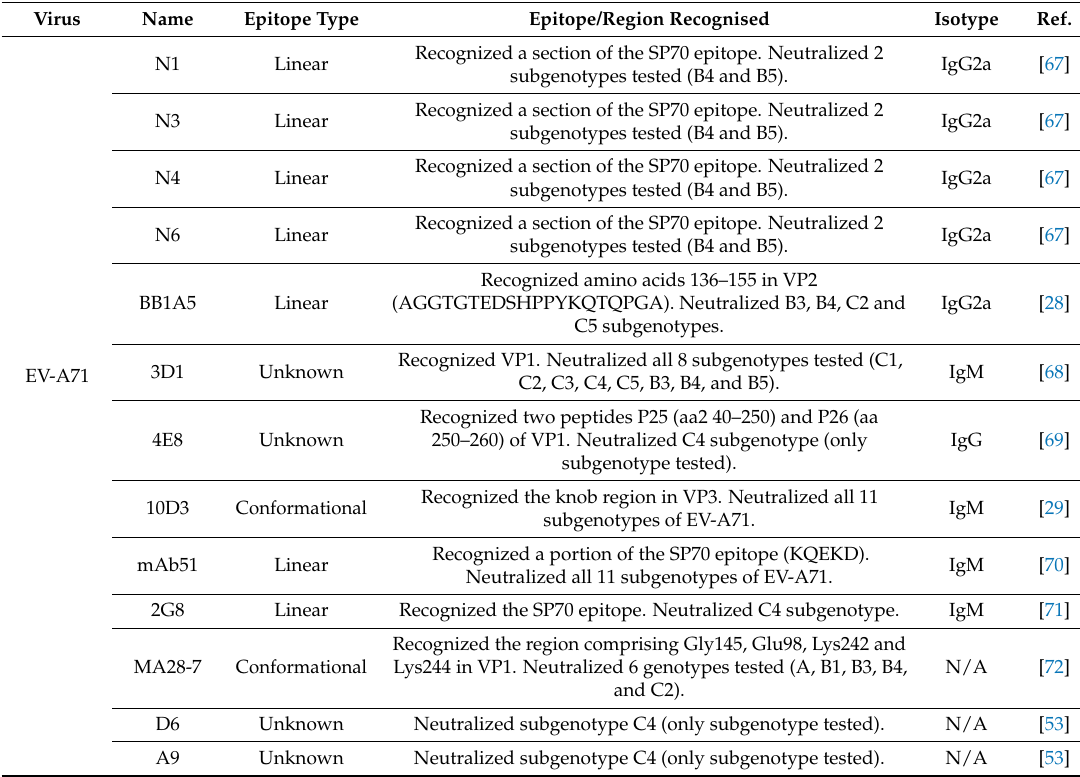
Table 2. Neutralizing monoclonal antibodies against EV-A71, CV-A16, CV-A6, and